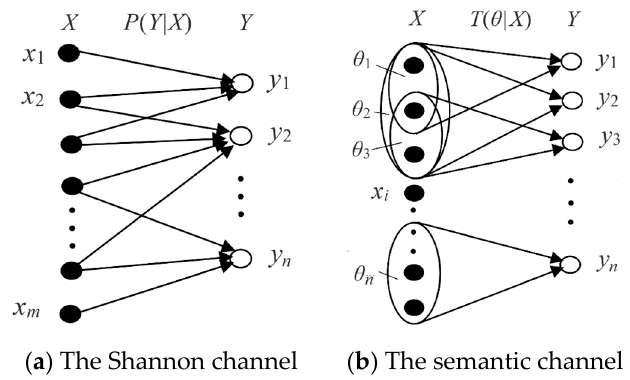
Figure 1. The Shannon channel and the semantic channel. The semantic meaning of y j is ascertained by the membership relation between x and θ j . A fuzzy set θ j may be overlapped or included by another.